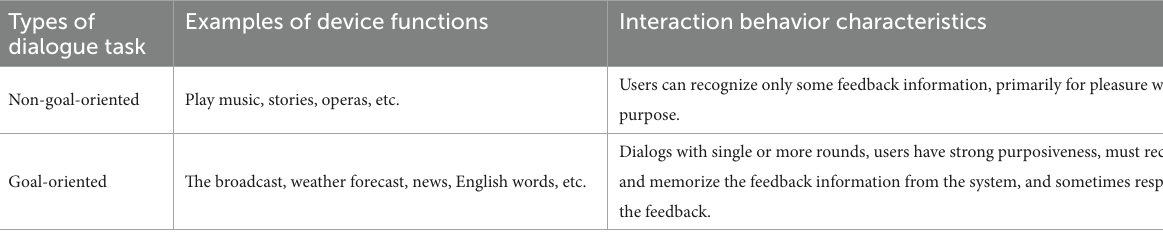
TABLE 1 Functions and dialog tasks classifications of voice interaction devices. Types of dialogue